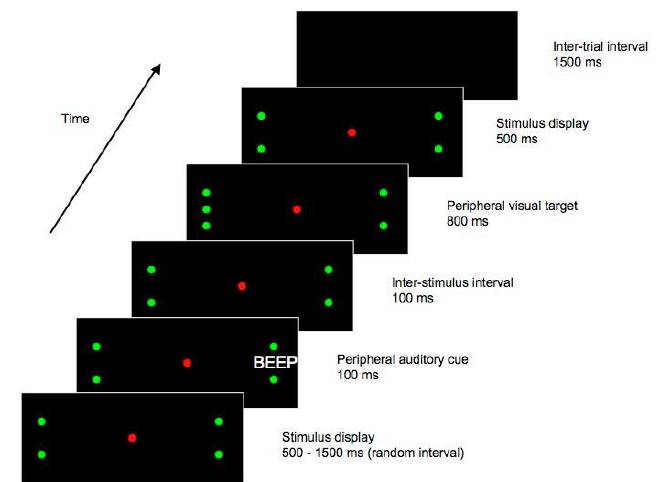
Figure 1: Stimulus sequence from Experiment 1. This figure shows one possible trial type, in which the target appears contralateral to the cue. In this example, the auditory cue is emitted from the right hand side of the display, and the subsequent target is presented on the left. Both cues and targets could also be presented on the opposite side of the display to that shown here, and on catch trials a target did not appear. Figure not to